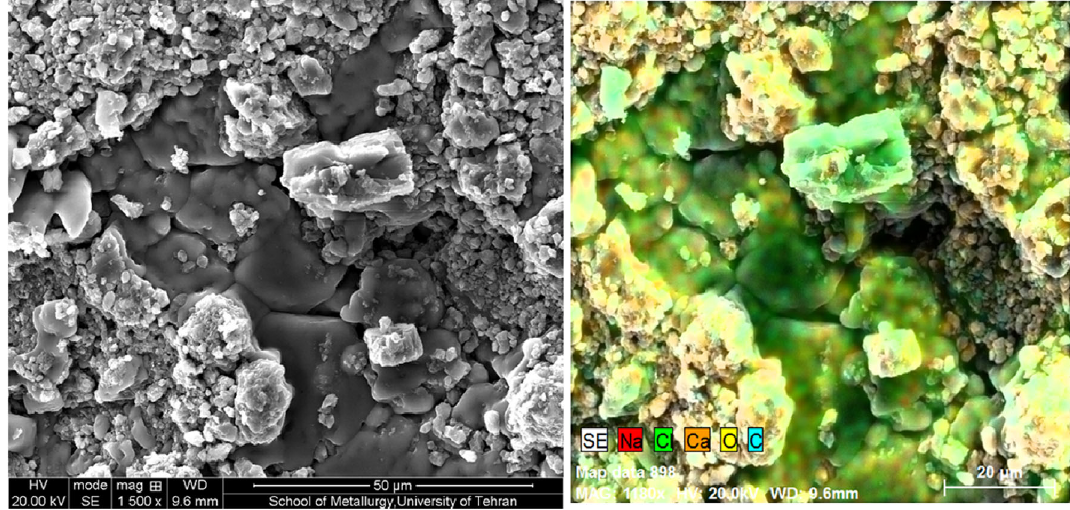
Fig. 5 EDS taken of saturated rock surface with